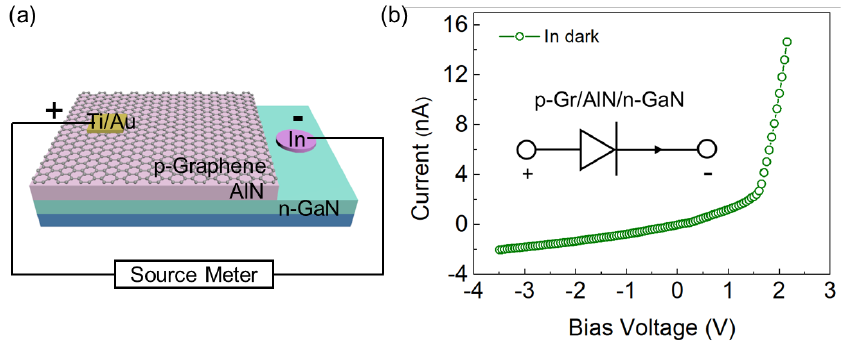
Figure 3. ( a ) Schematic diagram of a photovoltaic detector with a “sandwich” like structure of a p − graphene/i − AlN/n − GaN heterojunction. ( b ) I − V characteristic curves of p − graphene/i − AlN/n − GaN heterostructures under dark conditions. Illustration is the equivalent circuit of the device.